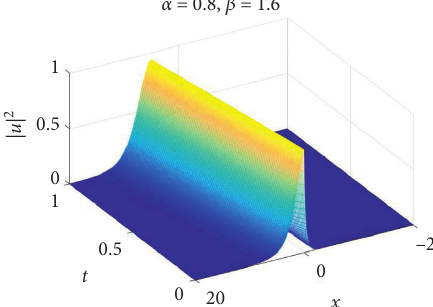
Figure 3: The trace of the solution to | u | 2 of FCNLSE (32) with α � 0 . 8 and β � 1 .